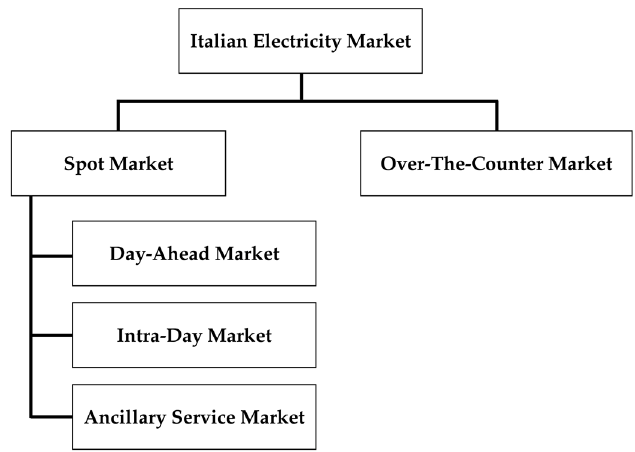
Figure 1. Structure of the Italian Wholesale Electricity Market.